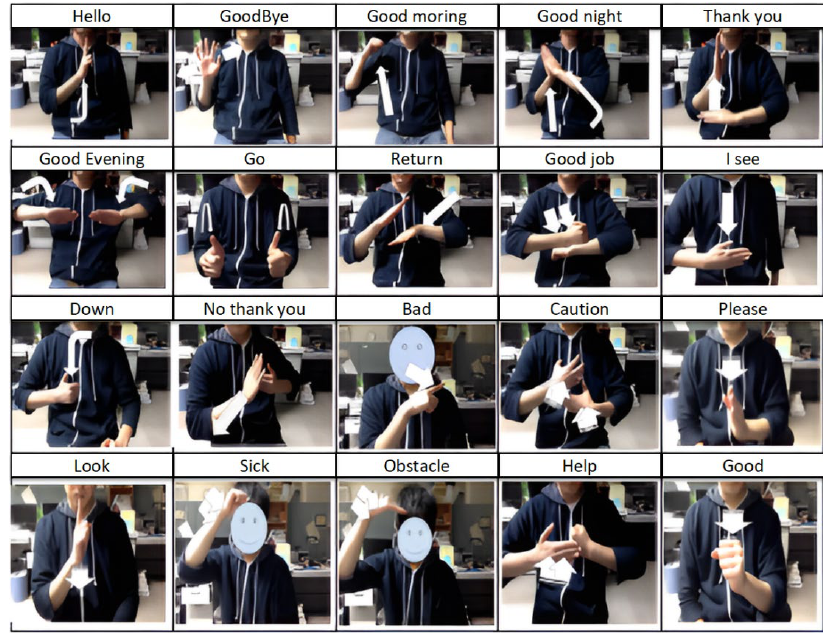
Figure 4. Selection of sign language vocabularies with both hand shape and hand motion factors.